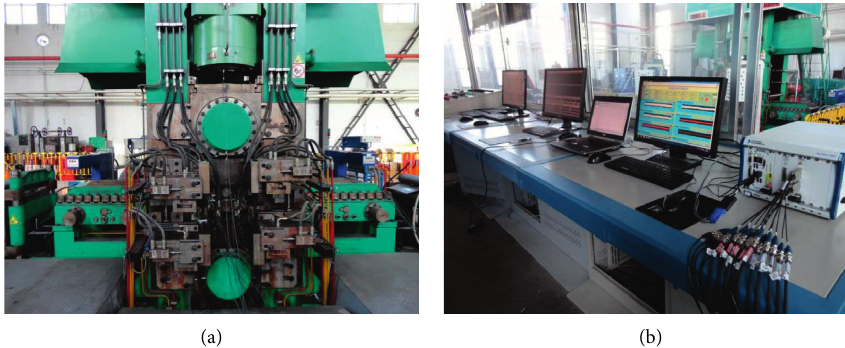
Figure 11: Photos of test system. (a) Test platform. (b) Computer control and data acquisition